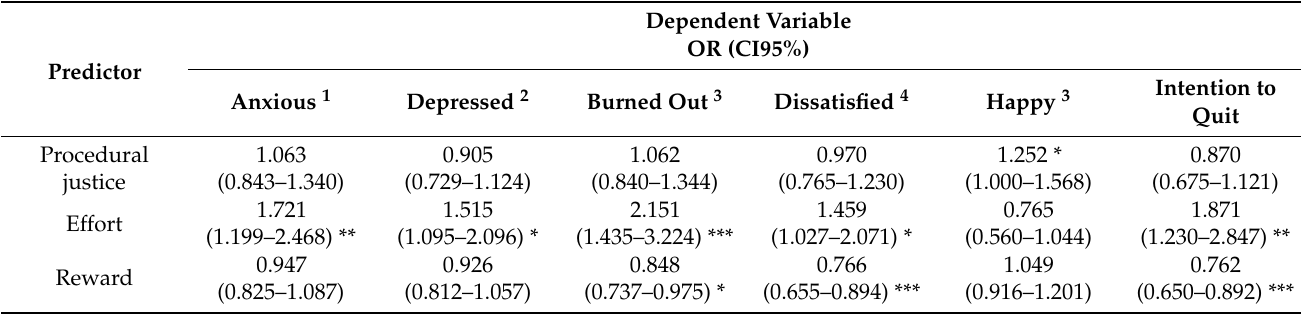
Table 6. Third wave health outcomes associated with procedural justice and occupational stress: a multivariate logistic regression model adjusted for age and